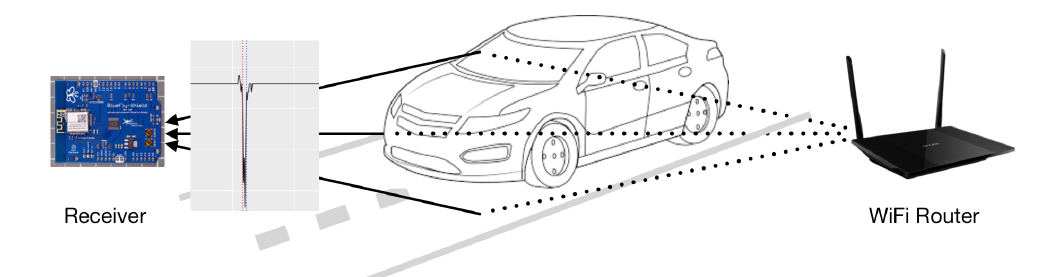
Figure 1. Illustration of deployment plan for the proposed hardware